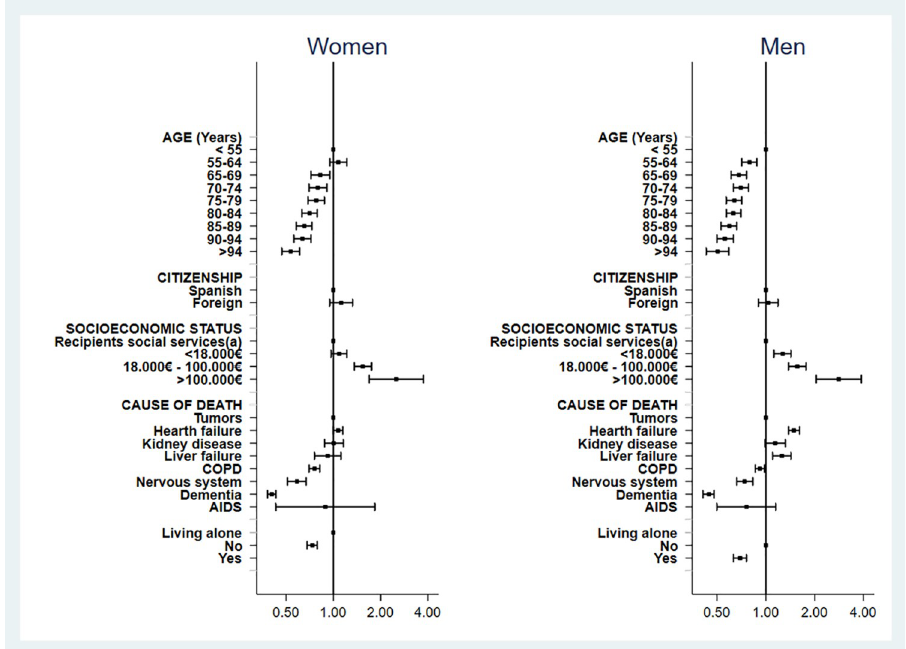
Fig 3. Adjusted model of percentage of days spent at home within the last 180 days of life, according to gender. Squared dots and lines show the odds ratio and 95% confidence interval of spending a higher percentage of days at home compared with the reference category. The model has been adjusted for all investigated variables. (a) Includes individuals perceiving a minimum integration income, unemployment allowance, unemployment benefit or not qualifying for either of the previous nor other